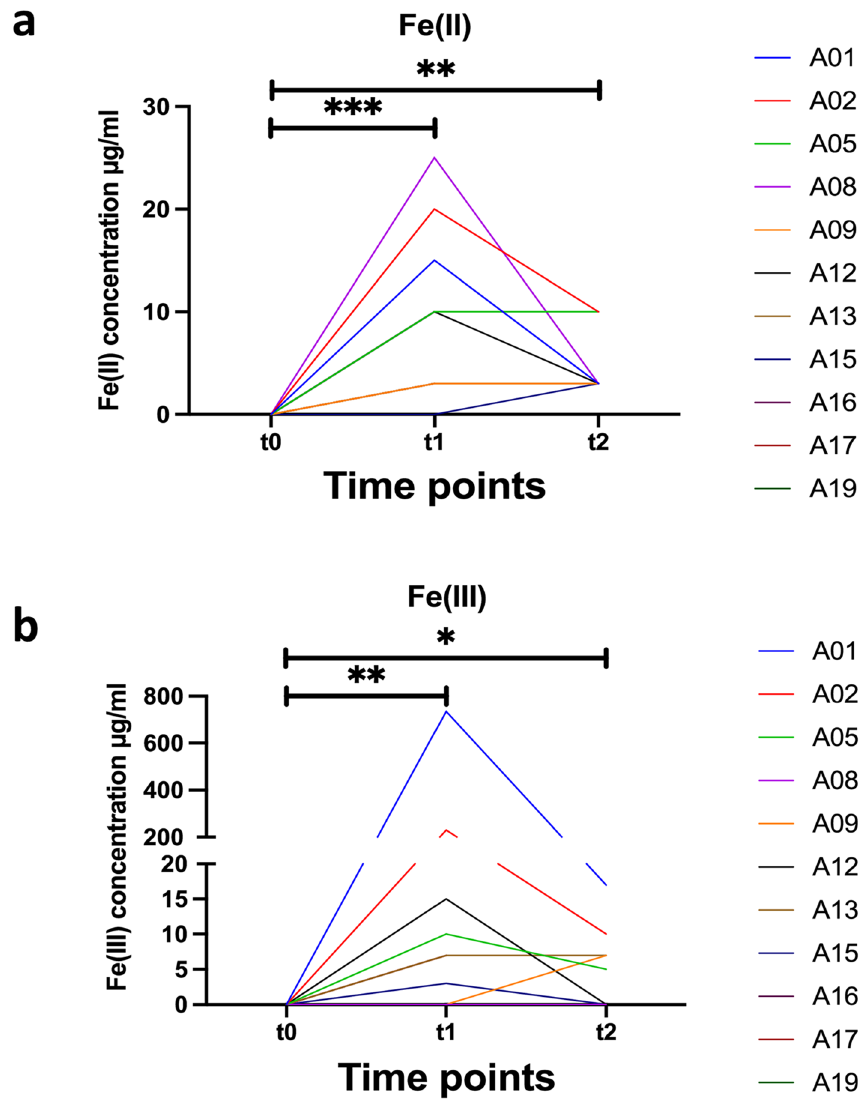
Figure 6. Dynamic of ( a ) Fe(2+) and ( b ) Fe(3+) detected at t0, t1 and t2 in the fecal supernatant of all 11 patients. The statistical analysis was performed using the non-parametric one-way ANOVA (Kruskal–Wallis) as non-pairing due to the missing measurements of patients A16, A17 and A19 at t2. The significance threshold was set at p = 0.05. For Fe(2+) ** = 0.0028 and *** = 0.0003; while for Fe(3+) * = 0.0424 and ** =